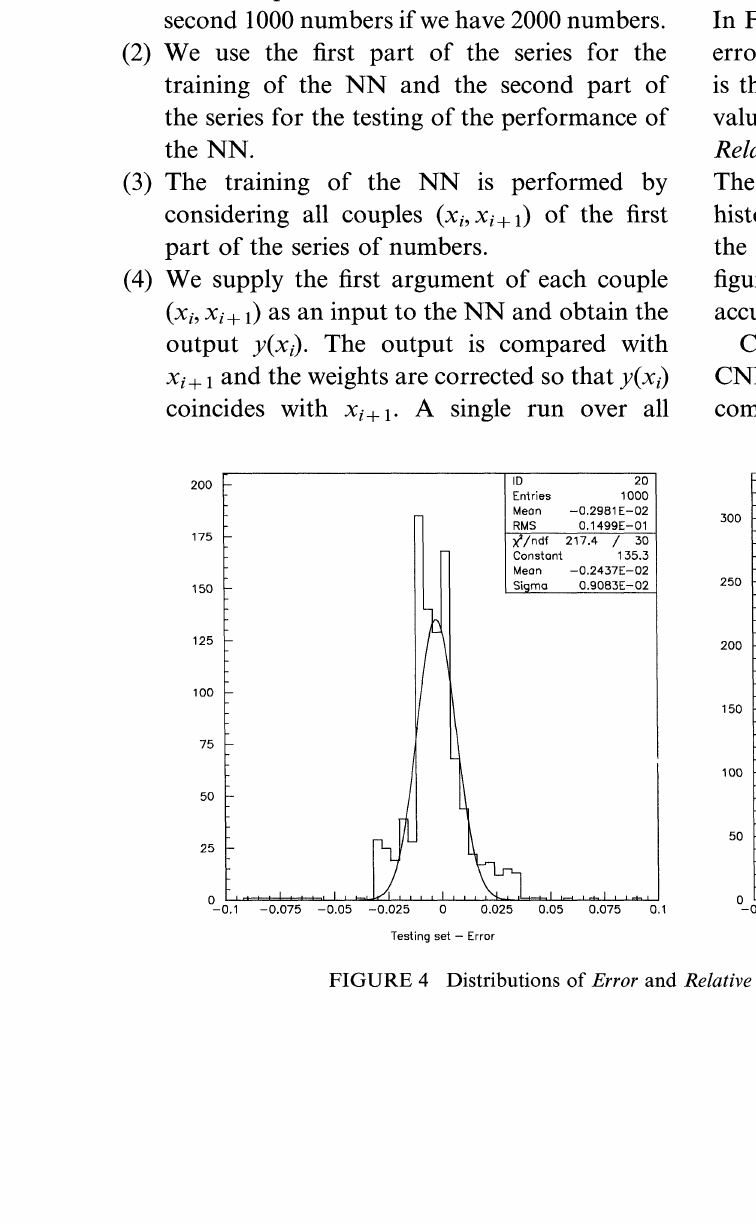
FIGURE 4 Distributions of Error and Relative error for the MLP neural